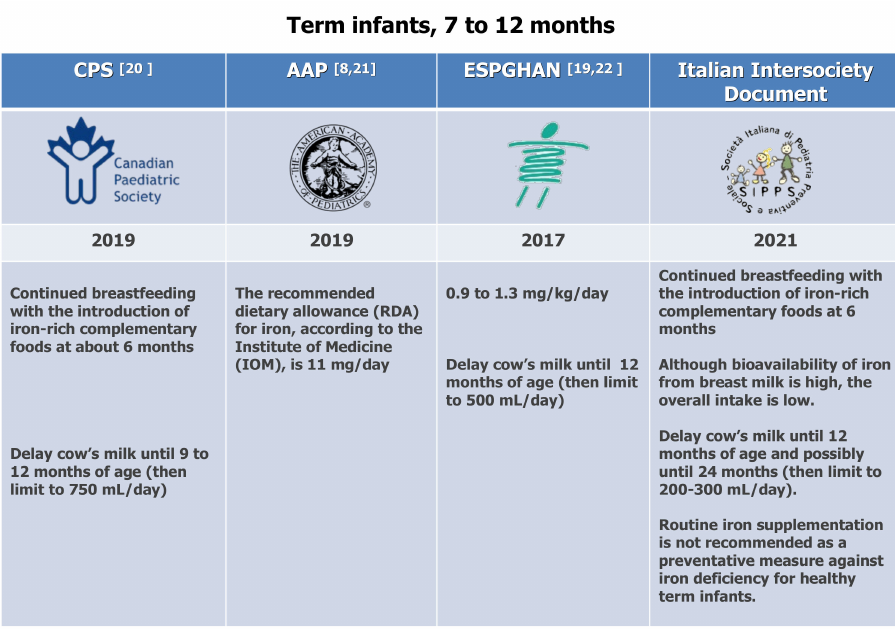
Figure 2. Dietary recommendations for term infants at 7 to 12 months. CPS [20], AAP [8,21], ESPGHAN